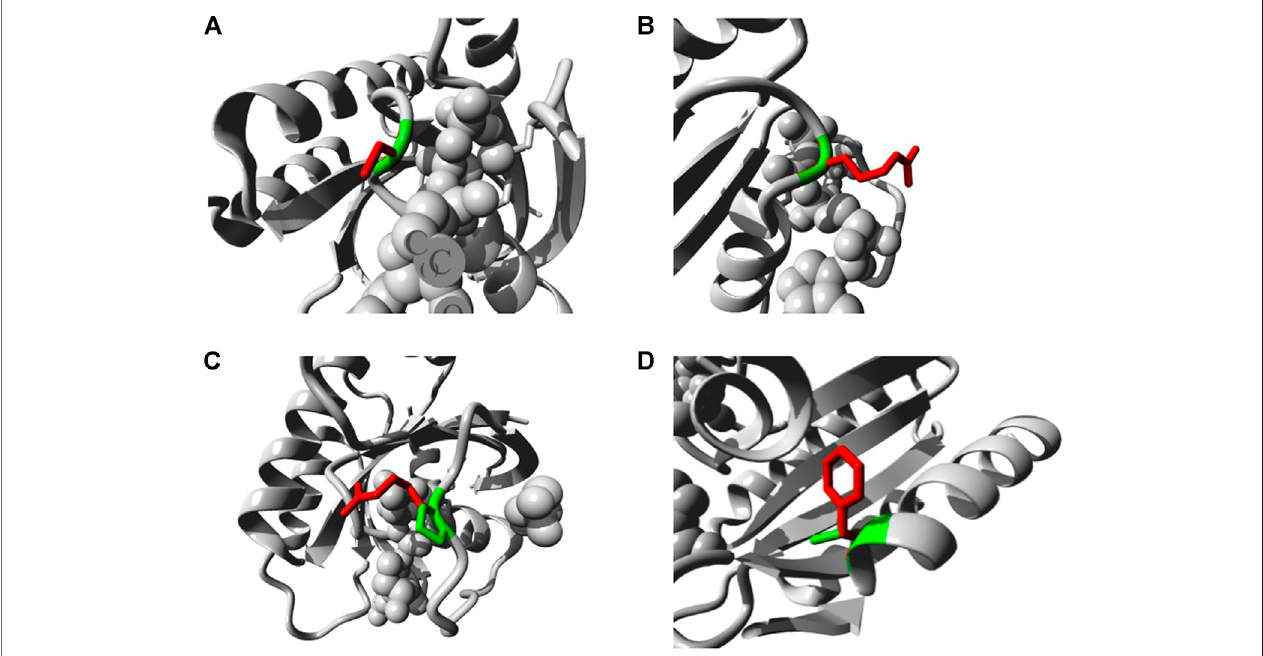
FIGURE 6 | Illustration of the substitution of wild type amino acid (green colored) by the mutant one (red colored) in different NRAS SNPs (A) G13C. (B) G13R. (C) P34R. (D) V152F.